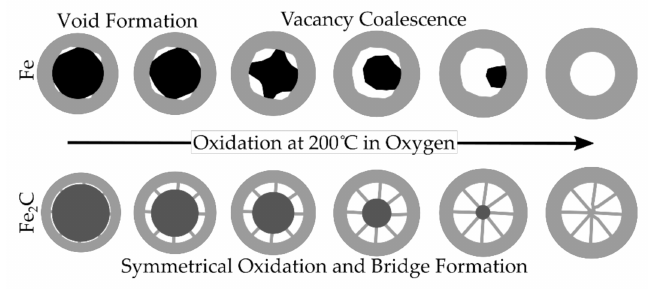
Figure 9. Schematic of the observed oxidation pathways of Fe and Fe 2 C indicating the initial void formation and coalescence that occurs during the oxidation of Fe, and the oxide bridge formation and growth of the shell that occurs with the Fe 2